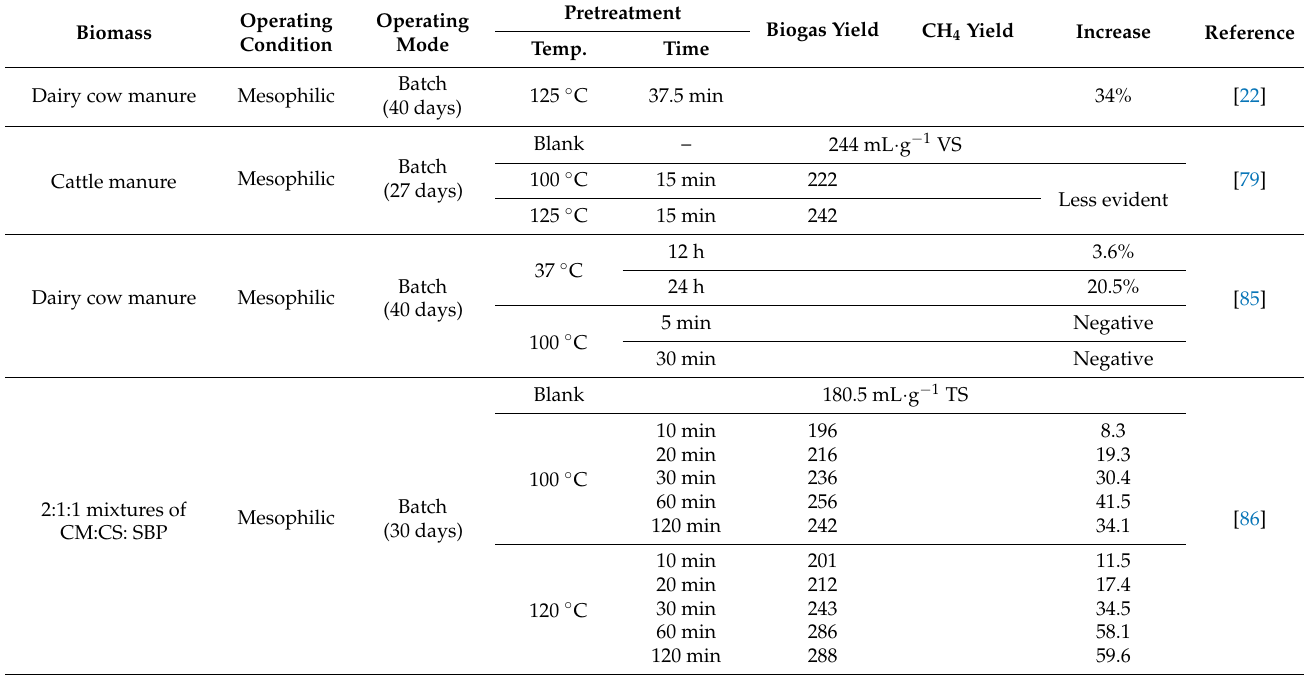
Table 3. Biogas production variation of dairy/cattle manure after LTPT (Temp. ≤